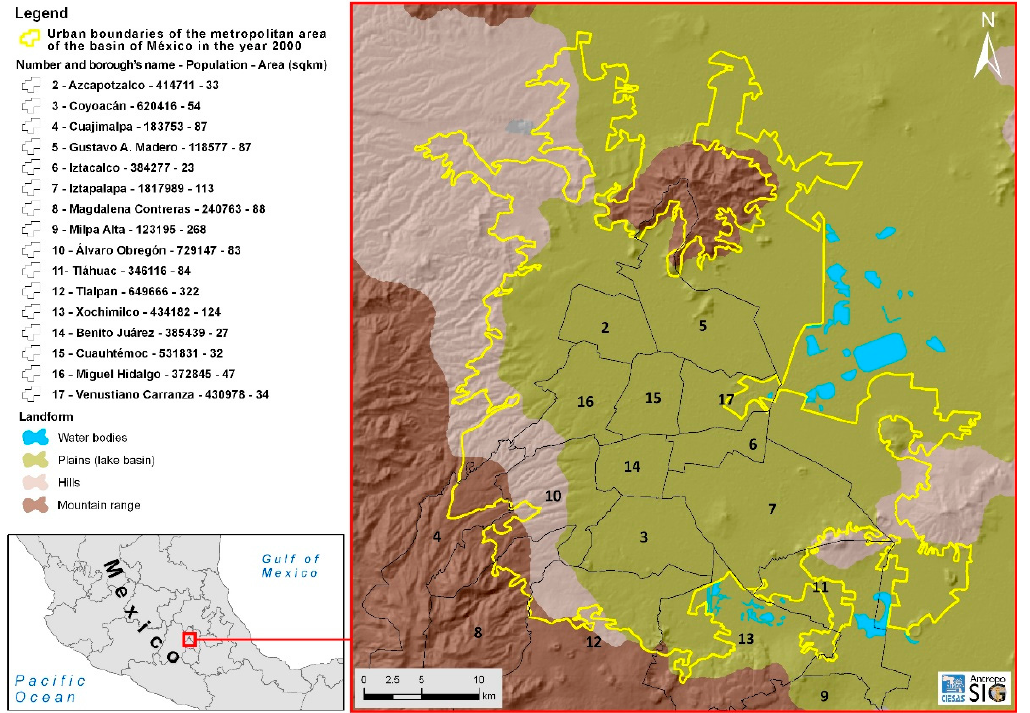
Figure 1. The geography of the Metropolitan Zone of the Valley of Mexico (MZVM).